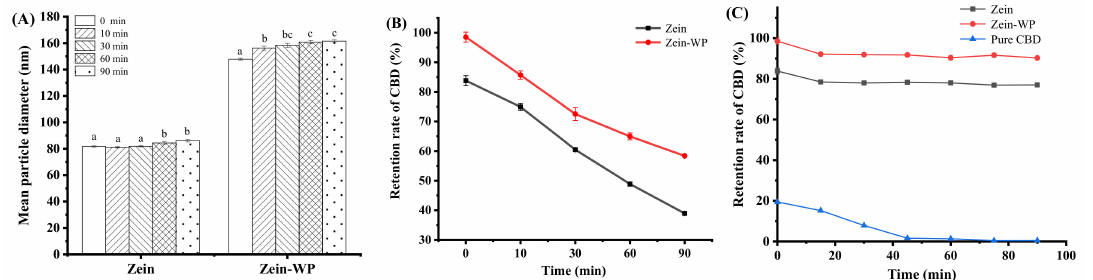
Figure 6. Effects of environmental stress on properties of nano-dispersions. ( A , B ) The mean particle diameter and CBD retention rate of nano-dispersions after heating at 80 ◦ C for 0–90 min; and ( C ) the retention rate of CBD in ano-dispersions and pure CBD under UV light irradiation for 90 min. Note: different lowercase letters indicate a significant difference ( p < 0.05) between samples s at different biopolymer